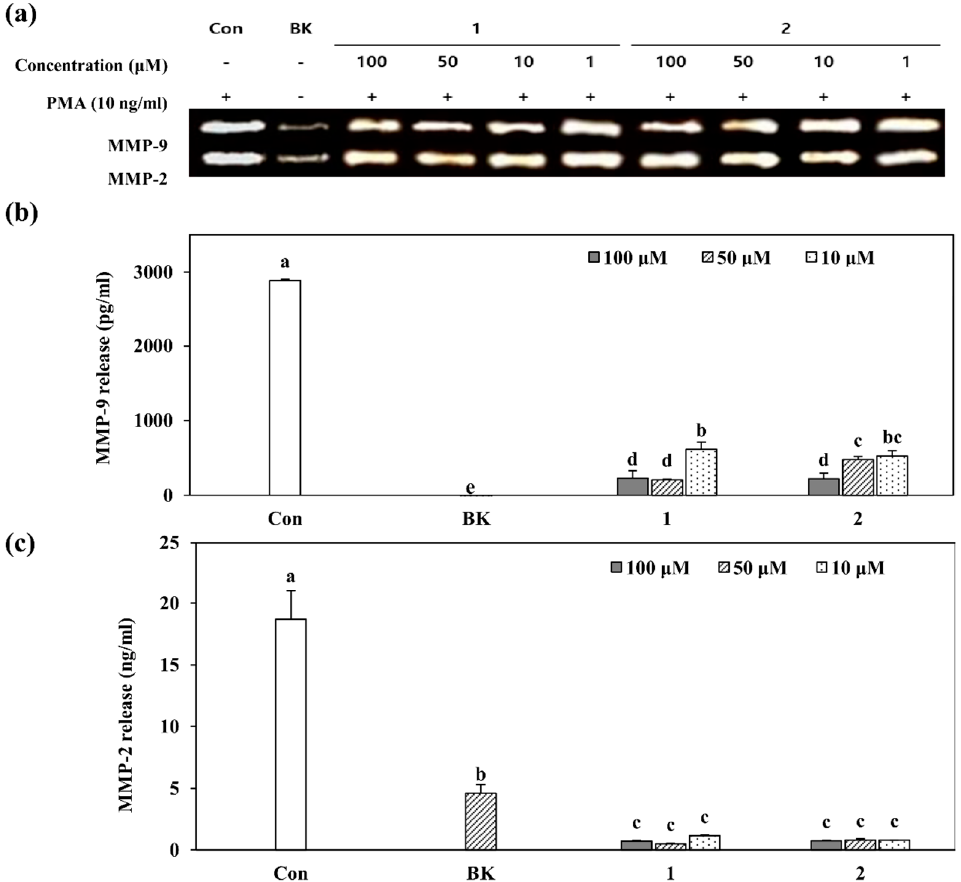
Figure 3. Gelatin zymography and ELISA showing the inhibitory effects of GL-3 ( 1 ) and oleonuezhenide ( 2 ) on enzymatic activity of MMP-2 and MMP-9 secreted by non-stimulated and PMA-stimulated HT-1080 human fibrosarcoma cells. ( a ) Cells were treated with indicated concentrations of compounds 1 and 2 for 24 h, and enzymatic activities of MMP-2 and MMP-9 from conditioned cell culture media were evaluated by electrophoresis of proteins on gelatin containing polyacrylamide gel. ( b , c ) Extracellular secretion levels of MMP-9 and MMP-2. Cells were treated with compounds 1 and 2 at indicated concentrations. Then, the cell culture medium was harvested and investigated by ELISA kits. Values are mean ± SD of three independent experiments. a–e Means with different letters are significantly different at p < 0.05 level. (BK: untreated unstimulated cells).